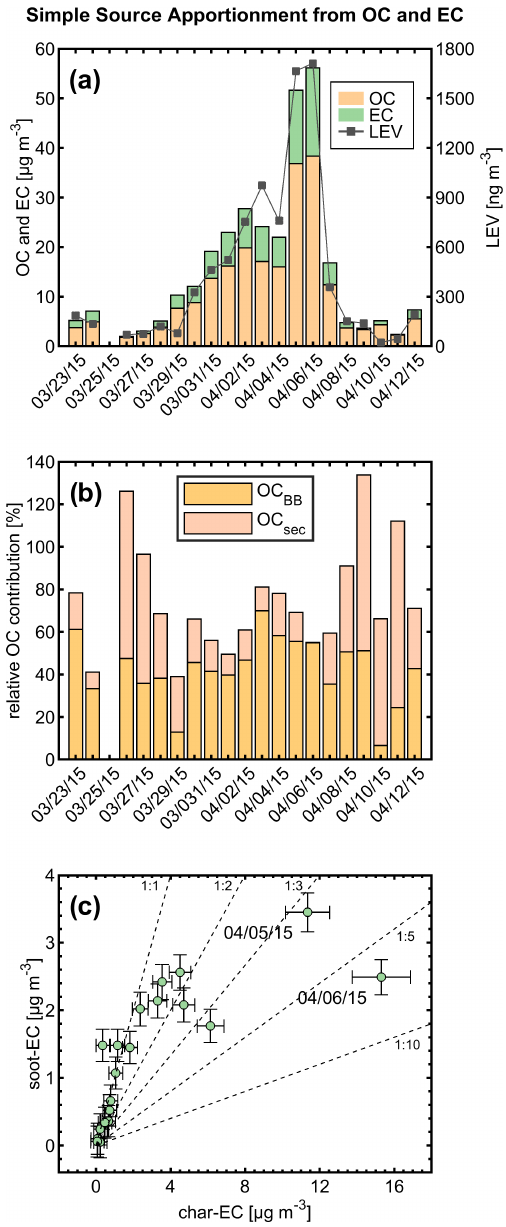
Figure 3. (a) Temporal variations of OC, EC, and levoglucosan (LEV) as BB markers in PM 2 . 5 at PDI during the sampling cam- paign from 23 March to 12 April 2015. (b) Relative contributions of primary OC from BB (OC BB ) and secondary organic carbon for- mation (OC sec ). (c) Scatterplot of char-EC vs. soot-EC during the sampling campaign. Error bars represent measurement uncertainty calculated with formula (1) with precision and LOD of 10% and 0.36µgm − 3 for char-EC and 5% and 0.23µgm − 3 for soot-EC, re- spectively. Dashed lines indicate the ratio of char-EC to